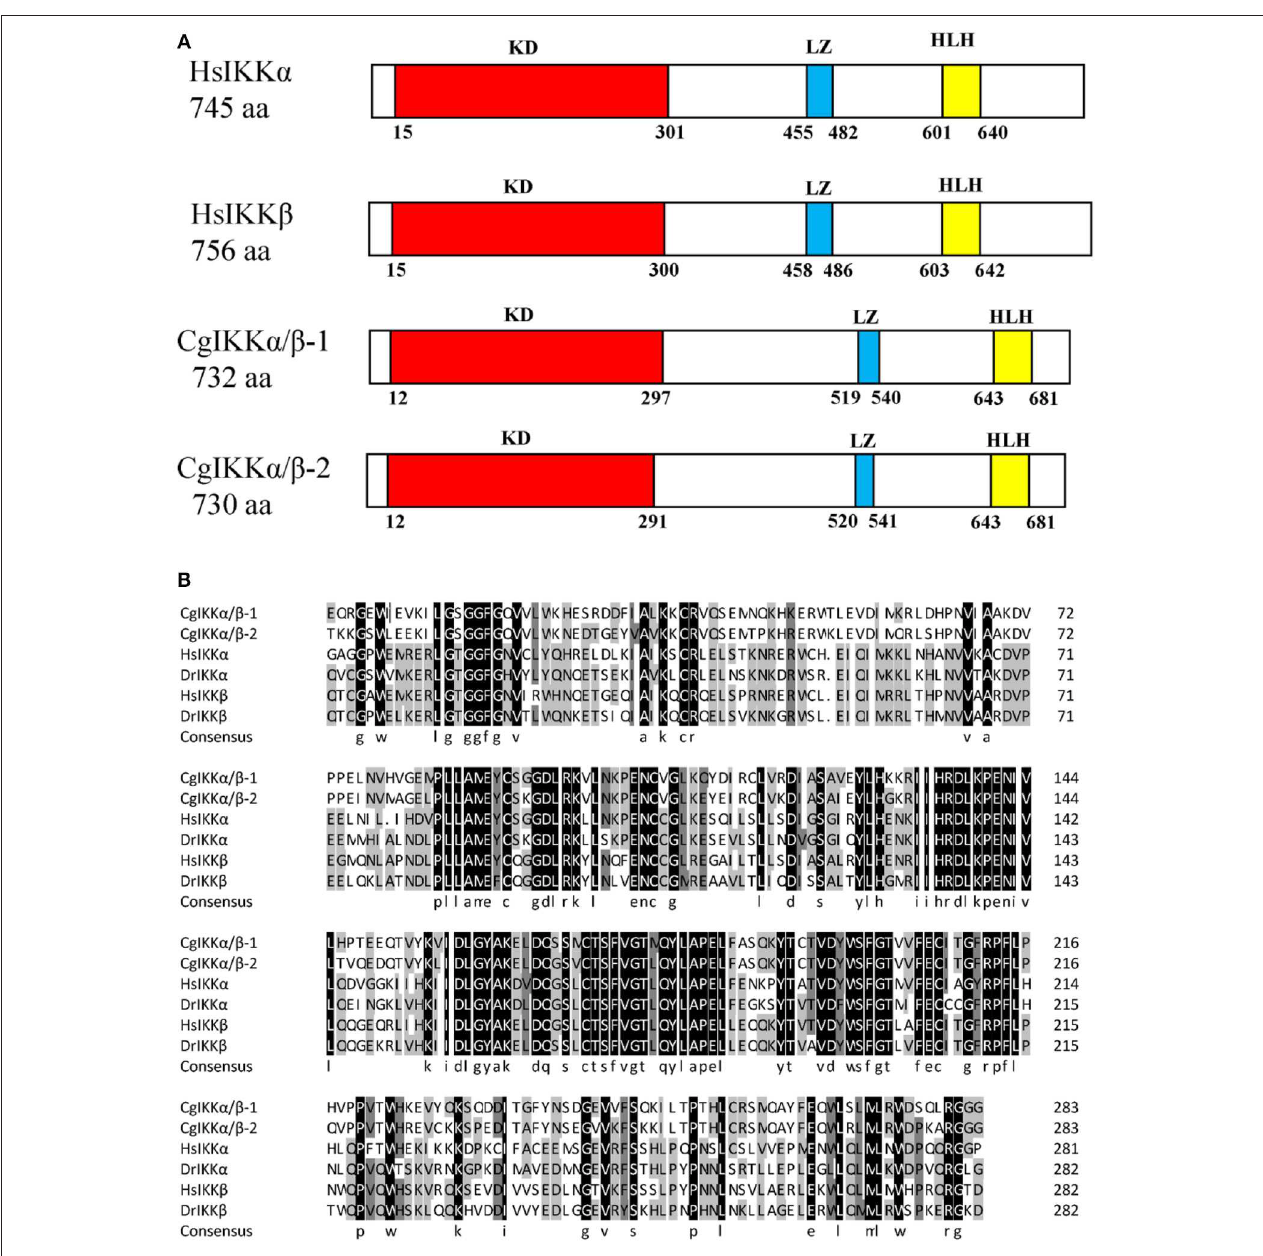
FIGURE 3 | Schematic representation of human and oyster IKK α / β protein structure (A) and multiple sequence alignment of IKK α and IKK β proteins from different species (B) . Sequences shaded in black are positions where all the sequences share the same amino acid residue, whereas those shaded in gray and light gray represent conservative and semi-conservative amino acid substitutions, respectively. Hs, Homo sapiens ; Dr, Danio rerio . The GenBank accession numbers for sequences used in this alignment are as the followings: HsIKK α (AAC51662.1), HsIKK β (AAC64675.1), DrIKK α (NP_956611.1), and DrIKK β (NP_001116737.1).